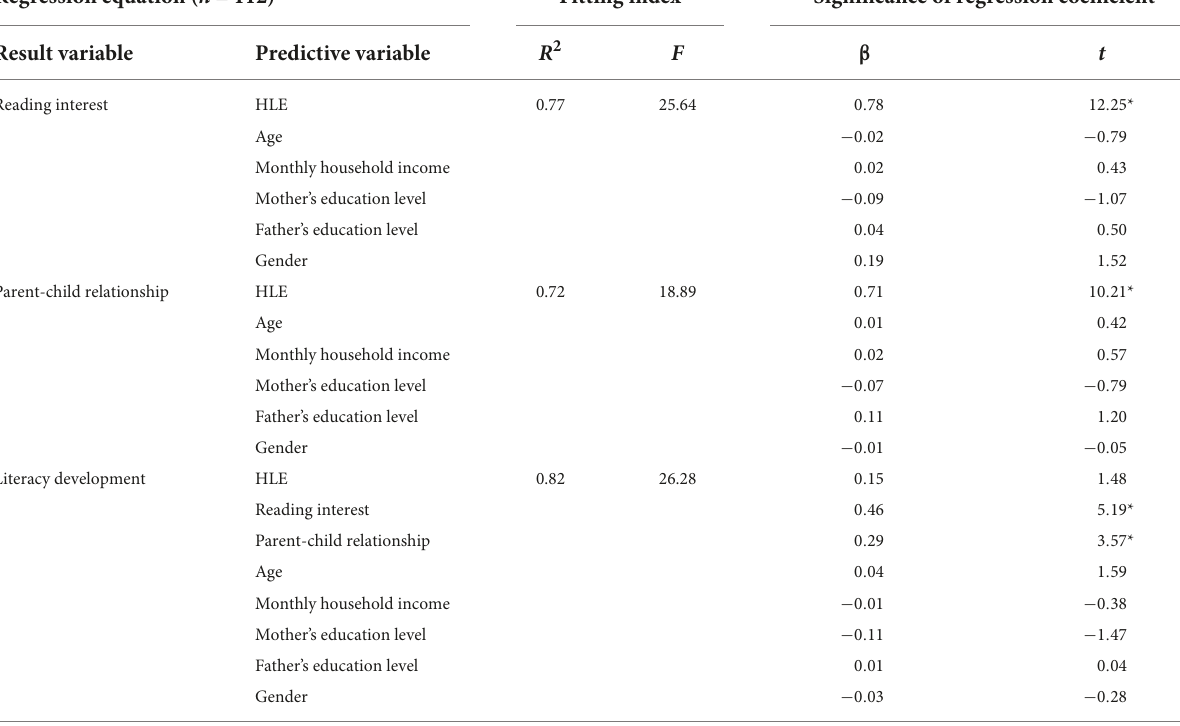
TABLE 3 Testing the mediation model of HLE’s influence on literacy development.